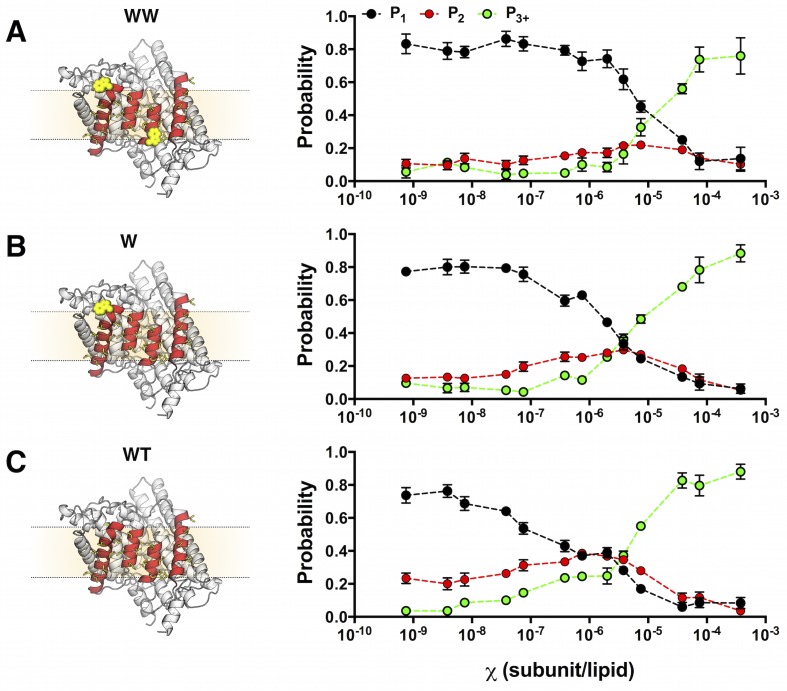
Photobleaching probabilities show a monomer to dimer transition that depends on the number of tryptophan residues at the dimerization interface.Left, single subunit of (A) WW ClC-ec1, (B) W and (C) WT in the lipid bilayer (beige rectangle, dotted lines) rotated to show the four helices that form the dimerization interface (red) and non-polar residues that line this surface (yellow, licorice). Tryptophan substitutions are shown in yellow VDW representation. Right, experimental Pexpt1-3+ at mole fraction densities χ = 7.5 × 10–10 to 3.8 × 10–4 subunit/lipid for (A) WT-Cy5, (B) W-Cy5 and (C) WW-Cy5. Data are reported as mean ± SE (n = 2–3 samples and 2–3 counters).DOI:
http://dx.doi.org/10.7554/eLife.17438.01510.7554/eLife.17438.016Figure 4—source data 1.Excel file including data and statistical analysis presented in Figure 4 including raw and averaged data for WT, W and WW photobleaching distributions.